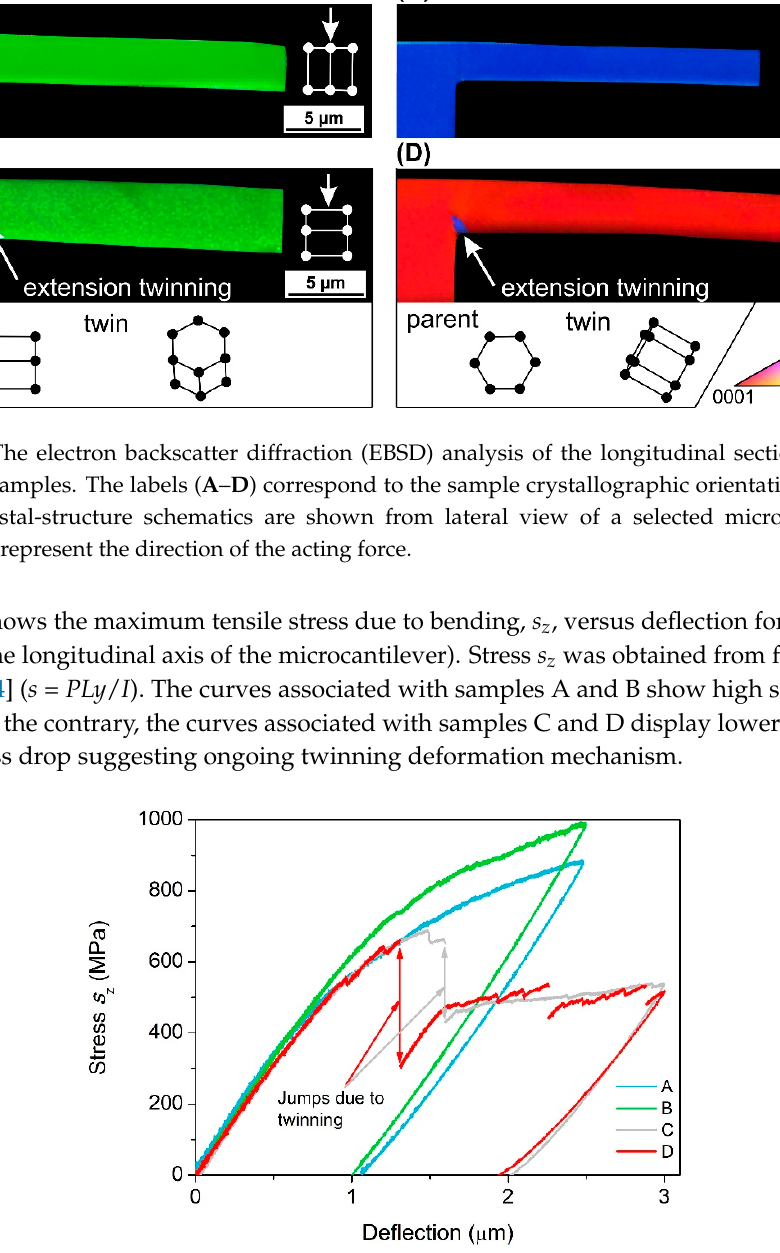
Figure 3. The diagram of stress s z versus deflection for representative samples A, B, C, and D.